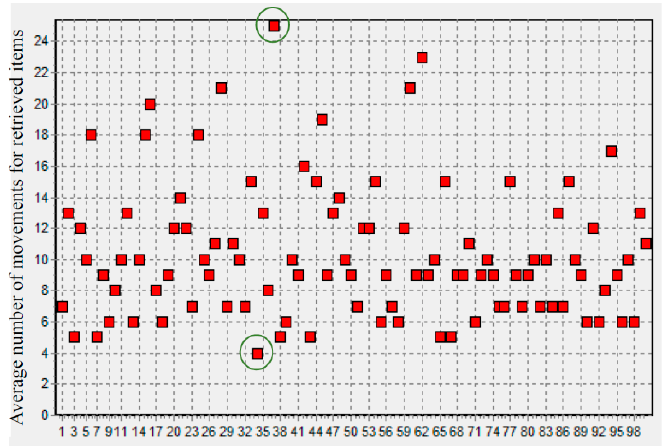
Figure 14. Average number of movements needed to retrieve items in every iteration of a 6 × 6 puzzle with 18 white cells.